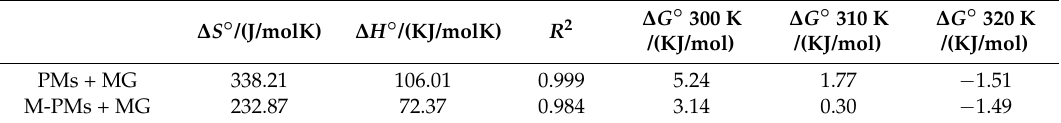
Table 3. Thermodynamic functions calculated for adsorption of MG by M-PMs and